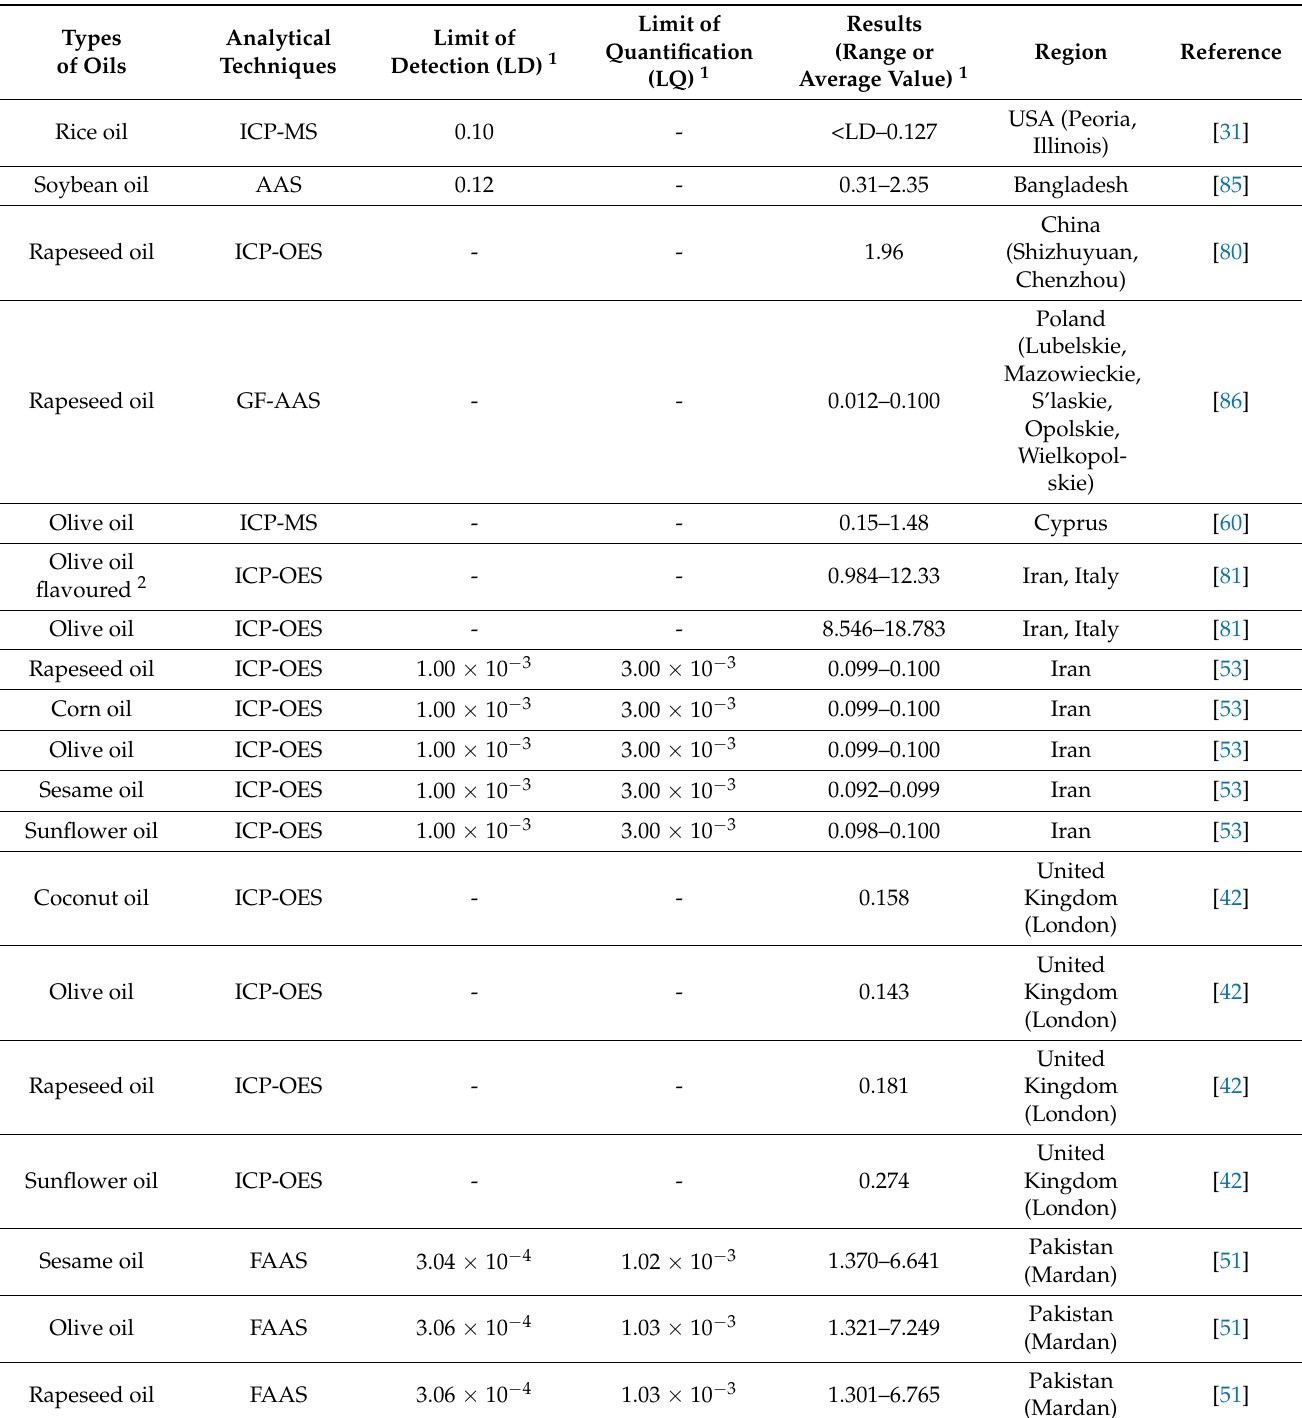
Table 4. Lead (Pb) content in edible vegetable oils, expressed in